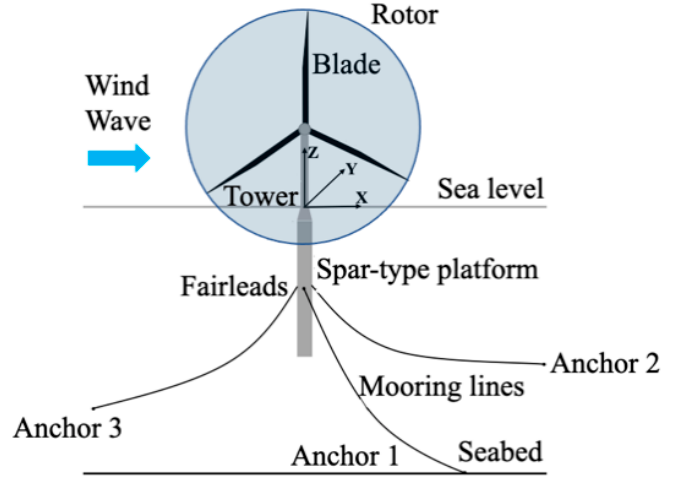
Figure 4. Schematic of OC3-Hywind spar-type 5 MW offshore wind turbine. Table 1. Key structural parameters of OC3-Hywind spar-type 5 MW offshore wind turbine.